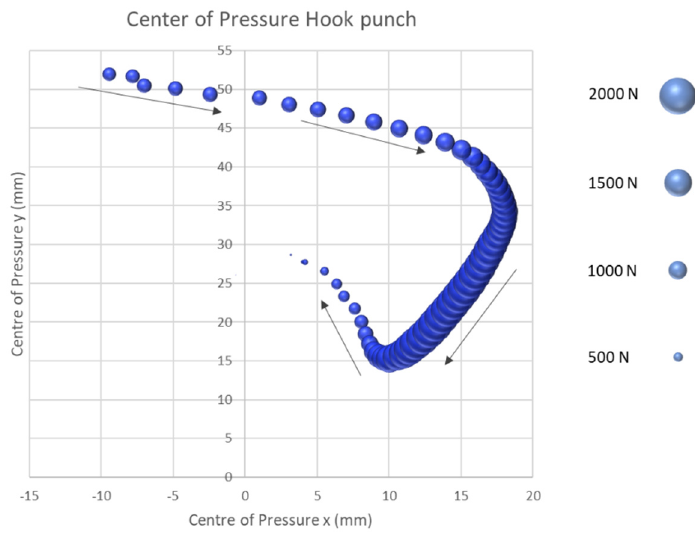
Figure 8. Centre of pressure hook punch.